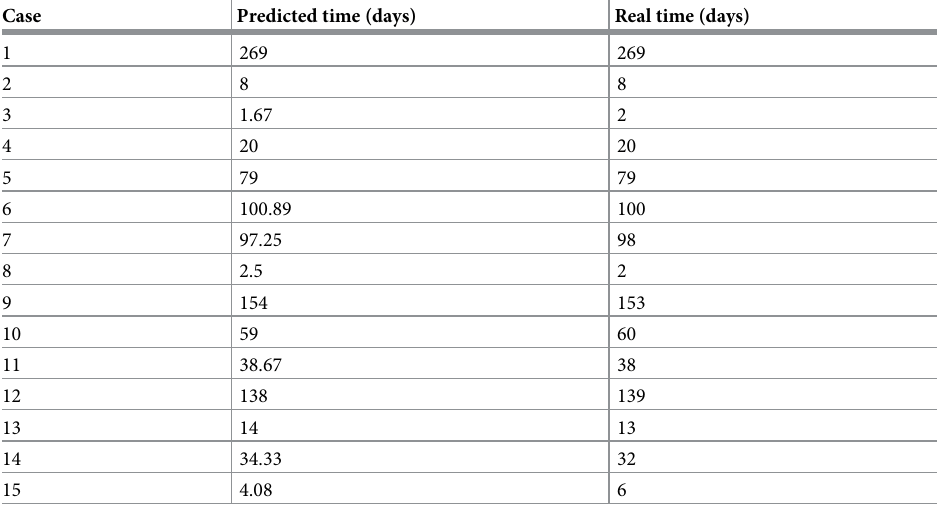
Table 10. Sample of the comparison of inference given by the adaboost algorithm and the real data. The case iden- tifier was modified for anonymization purposes. Case Predicted time